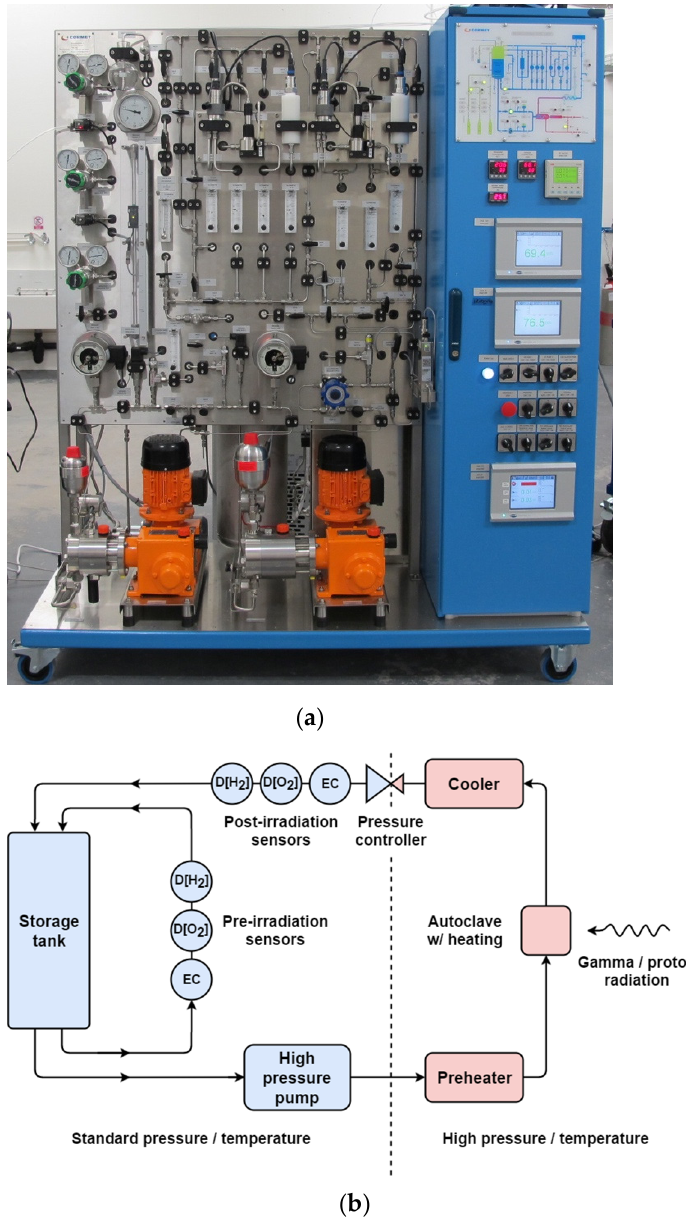
Figure 3. The Cormet™ Oy recirculation loop. ( a ) A photograph of the equipment which is about 1.8 m tall by 1.5 m wide. ( b ) A simplified schematic diagram of recirculation loop. Sensors labelled D[H 2 ], D[O 2 ] and EC monitor dissolved hydrogen (ppb), dissolved oxygen (ppb), and electrical conductivity, respectively.